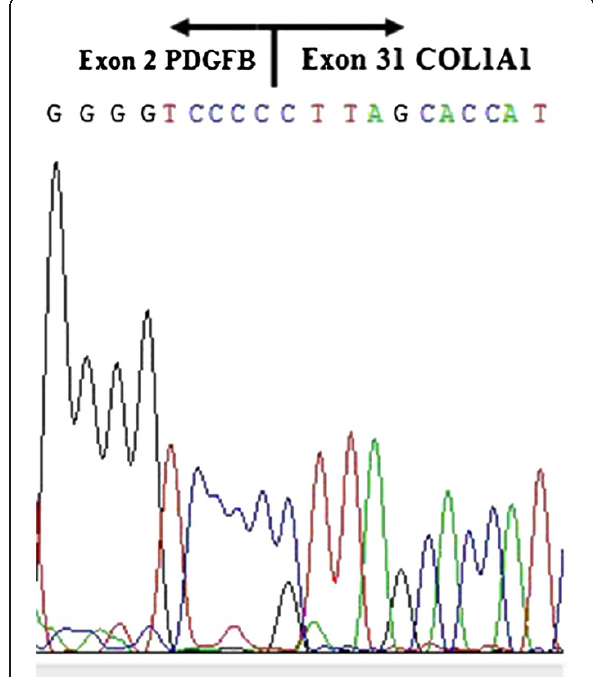
Figure 4 Detection of surgical specimen revealed a fusion of collagen 1 α 1 gene ( COL1A1 ) exon 31, to exon 2 of the platelet derived growth factor B gene ( PDGFB ).